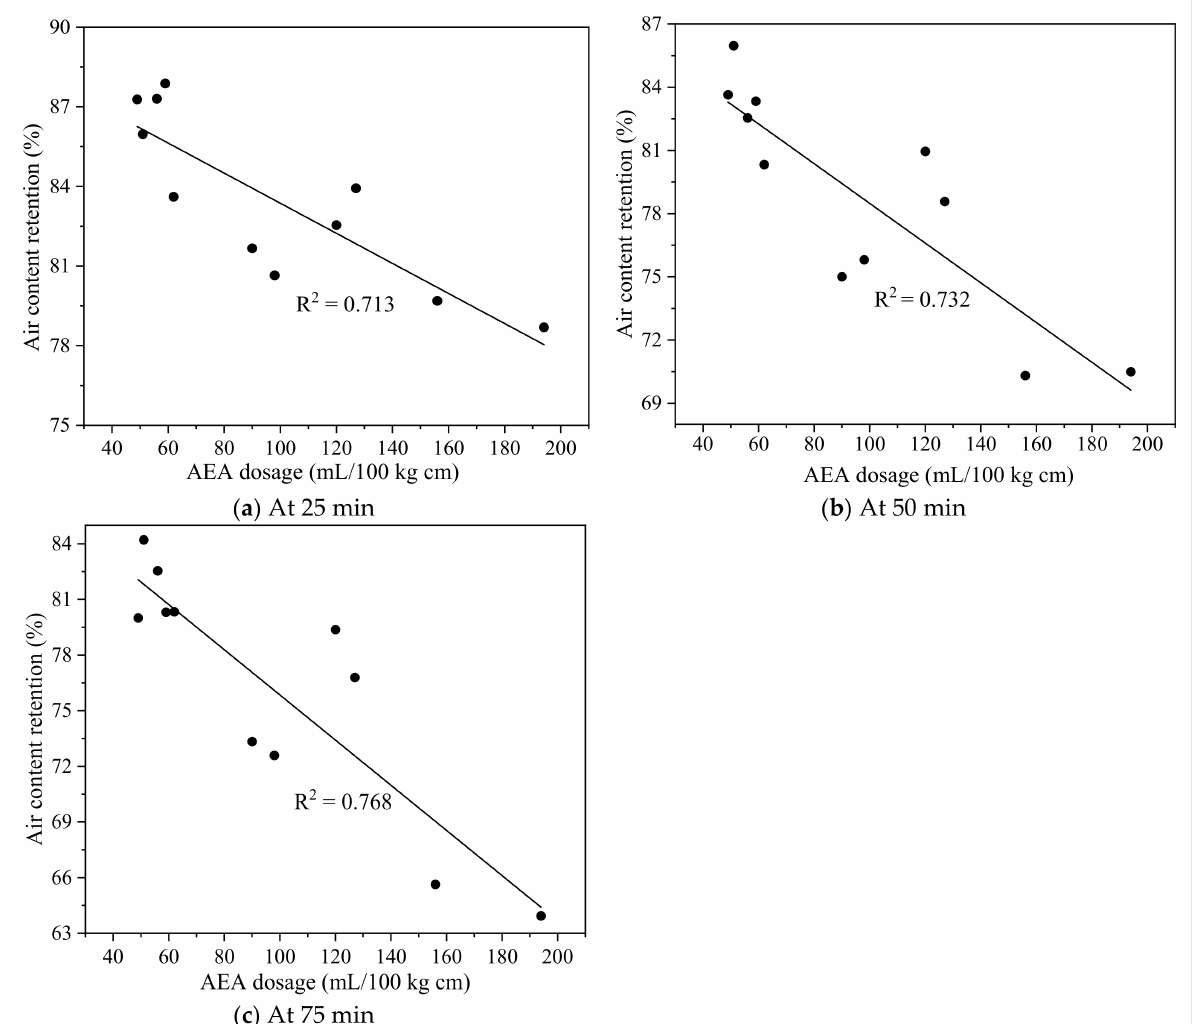
Figure 6. Correlation between air content retention and AEA demand ( a ) At 25 min ( b ) At 50 min ( c ) At 75